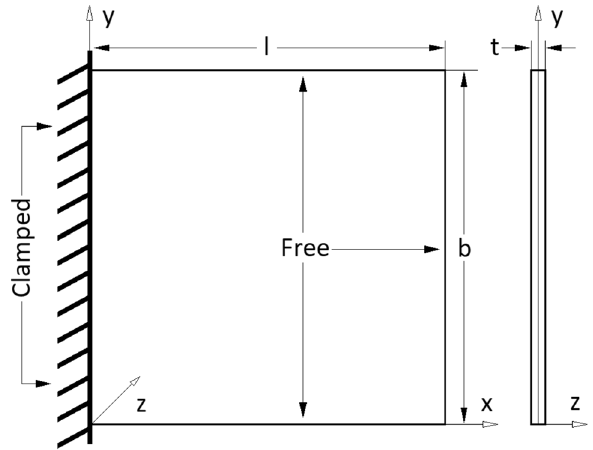
Fig. 4 Diagram and definition of the coordinate system of the setup including the boundary conditions. The plate has length l, breadth b, and thickness t. One side is clamped and the others are left free. The plate is free to move in the ± z-axis, away from the clamped